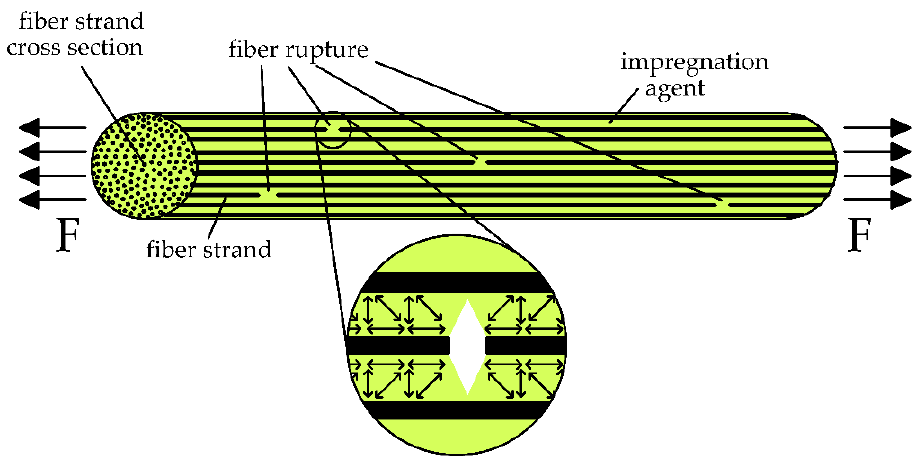
Figure 3. Bridging of filament breaks through the impregnating agent, adapted from [18].